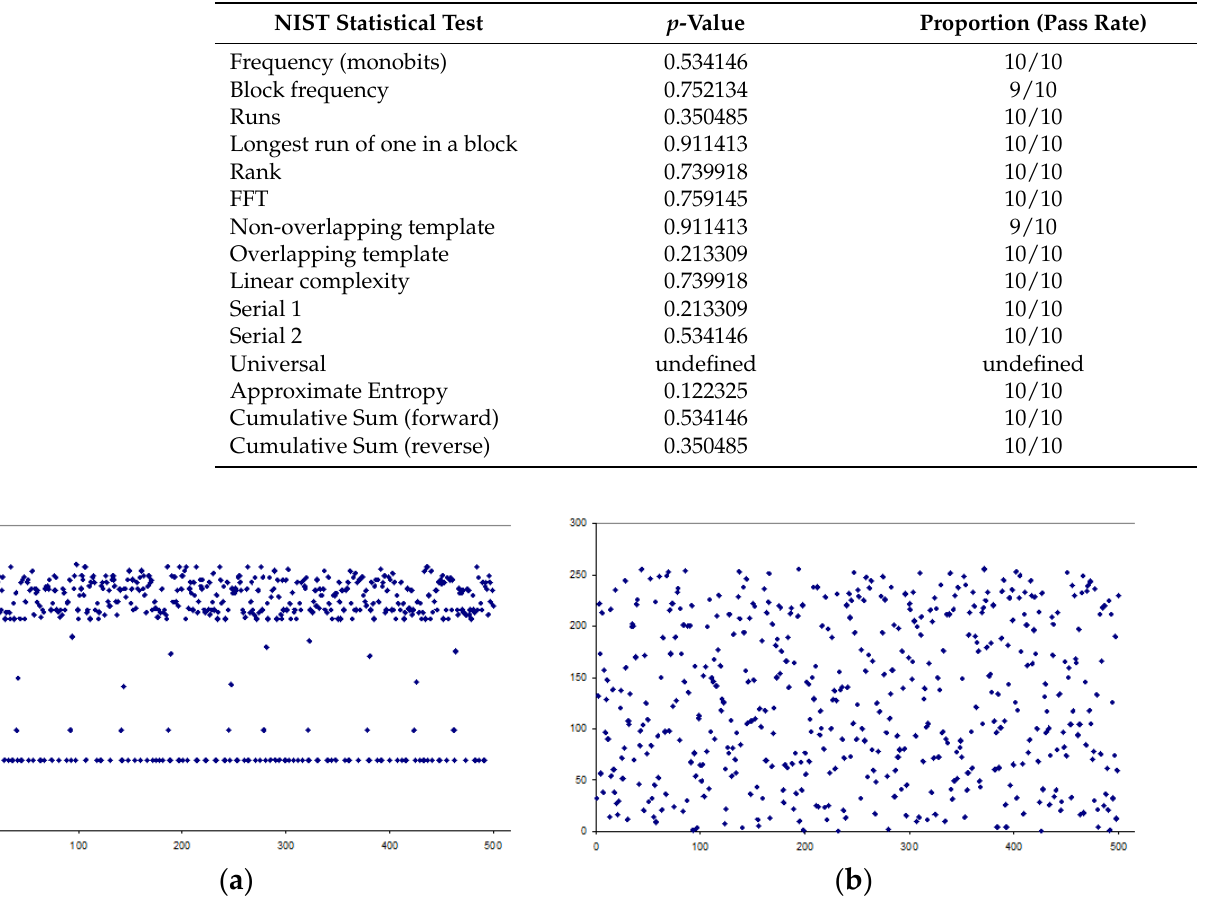
Table 4. Statistical testing results using NIST software.